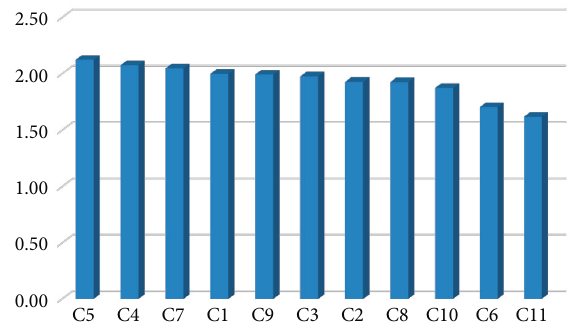
Figure 1: The impact of criteria.